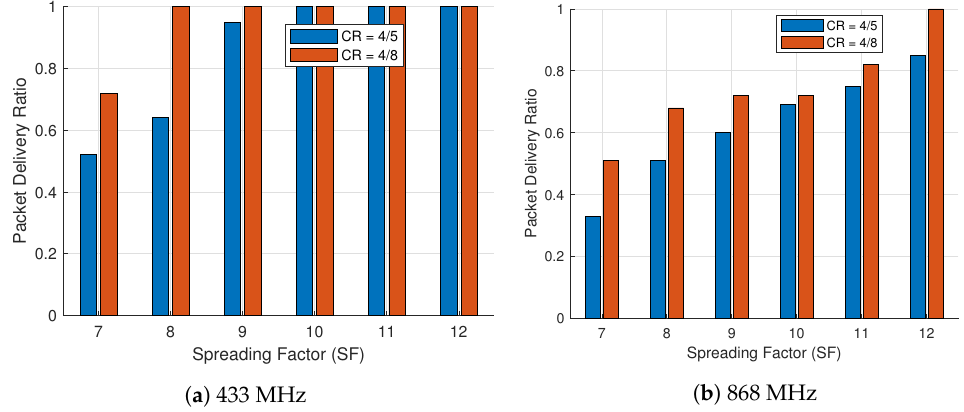
Figure 11. PDR vs. SF varying the CR in POS C ( a ) 433 MHz ( b ) 868